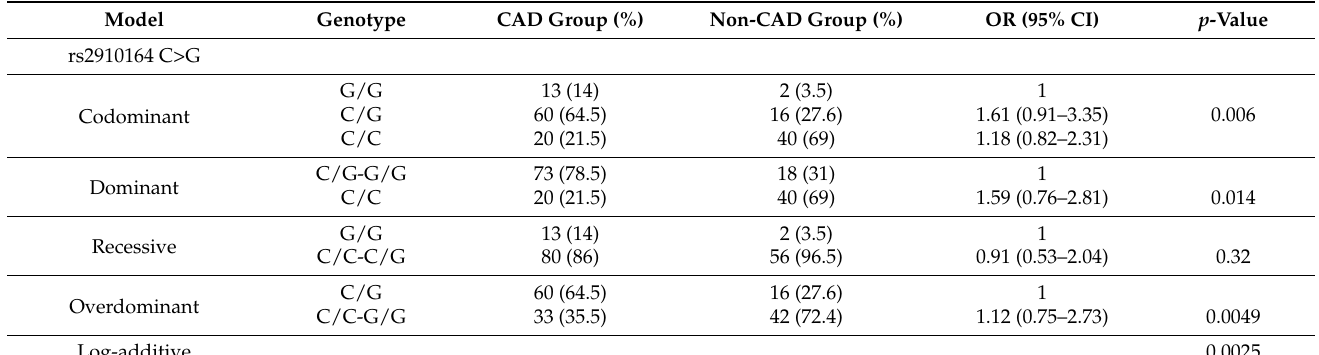
Table 2. Baseline characteristics between CAD group and non-CAD